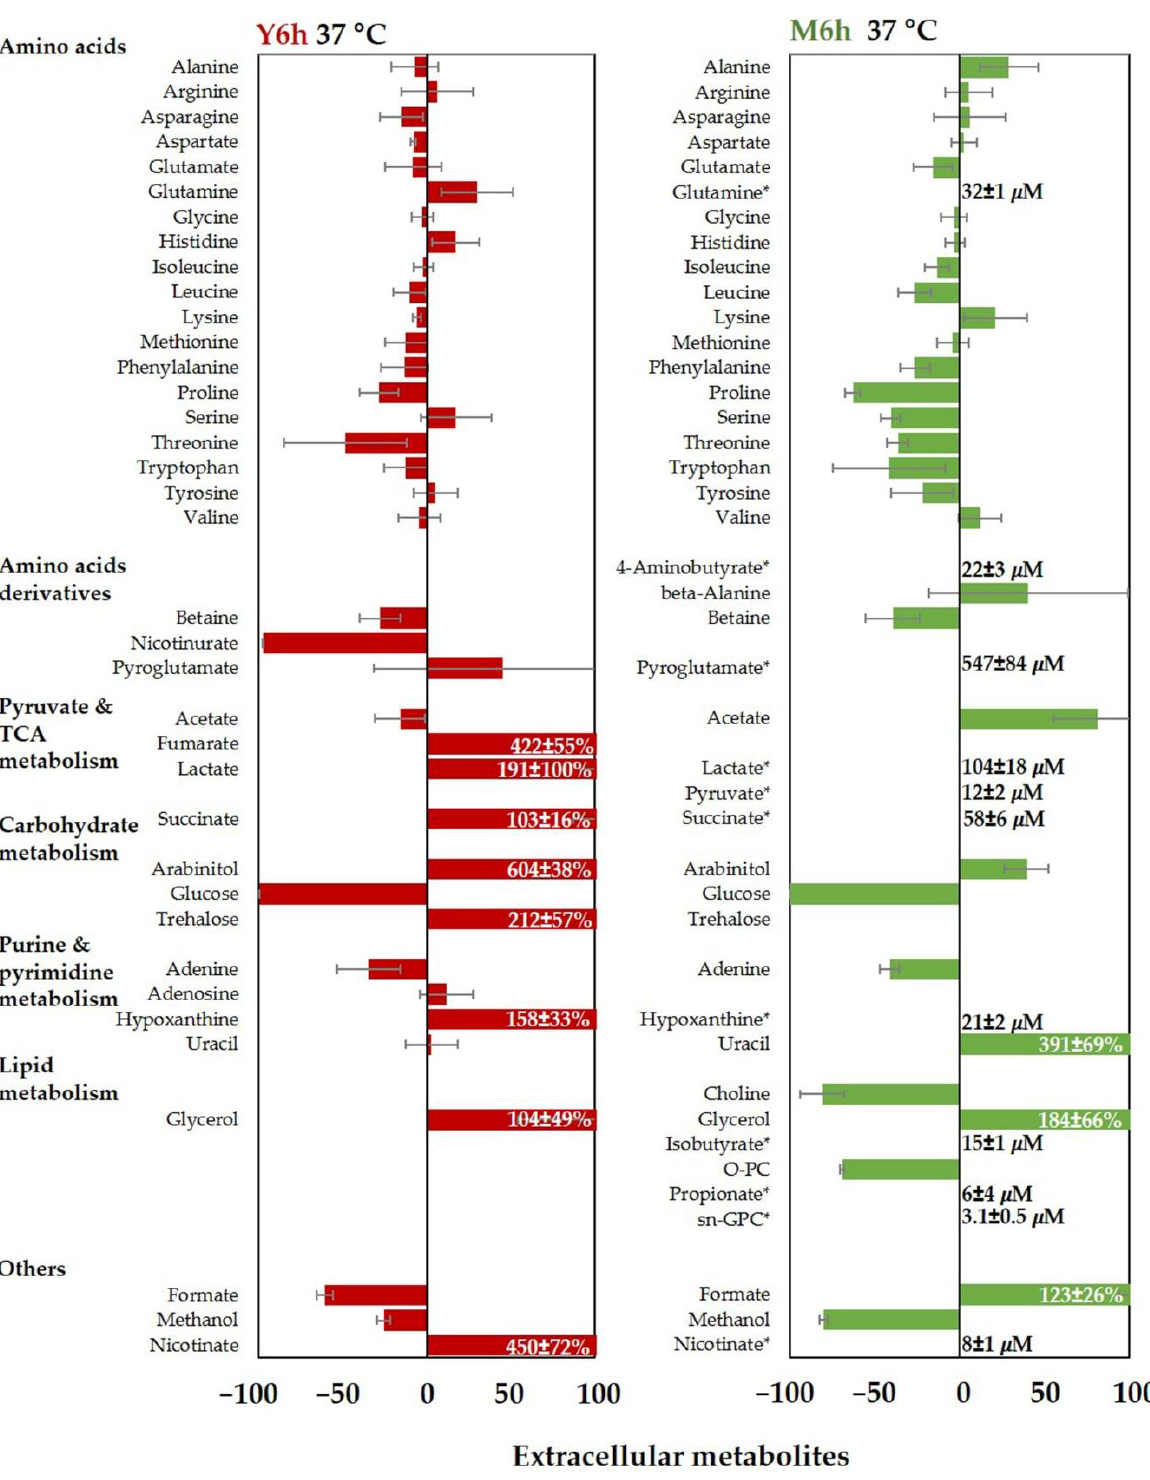
Figure 6. Changes in extracellular metabolite concentrations after 6 h of incubation at 37 °C in YPD (Y6h, red) and M199 (M6h, green). Data are reported as percentage variation of the metabolite concentrations with respect to fresh medium composition. Negative values correspond to metabolites extracted from the medium, while positive values correspond to metabolites released into the medium. TCA: tricarboxylic acid; O-PC: O-phosphocholine; sn-GPC: sn -glycerophosphocholine. The asterisk (*) indicates that the metabolite is present in the supernatant but is absent in the fresh medium, and its measured concentration is reported.